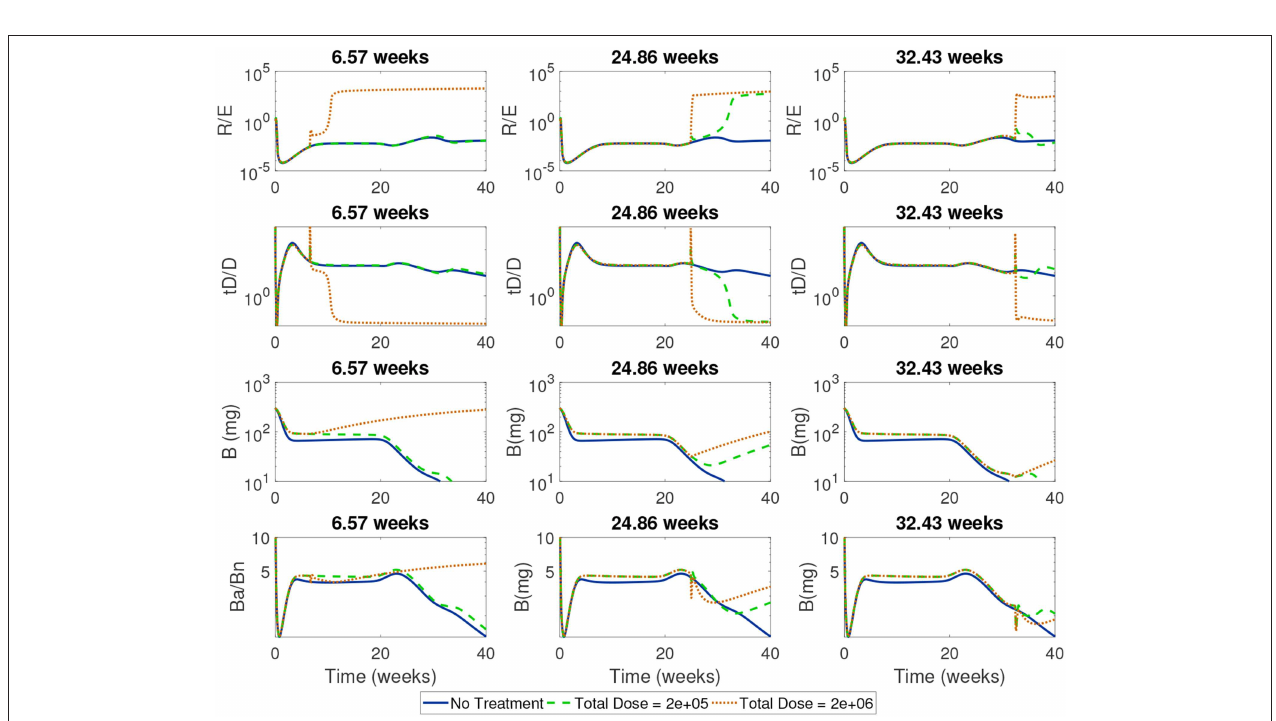
FIGURE 11 | Time-course of cell ratios with two doses (2 e + 05 and 2 e + 06) with treatment started at critical transition start times. At Start Time = 6.57 weeks, the high dose first becomes effective displaying a rapid increase in regulatory T cells followed by a slow increase in β -cells; the low dose treatment, however, is not able to alter the course of T1D development. At Start Time = 24.86 weeks the low dose first becomes effective at eliciting a Treg response which corresponds to a switch in the ratio of B a / B n and an increase in β -cell mass. At Start Time = 32.43 weeks the low dose is not effective anymore.